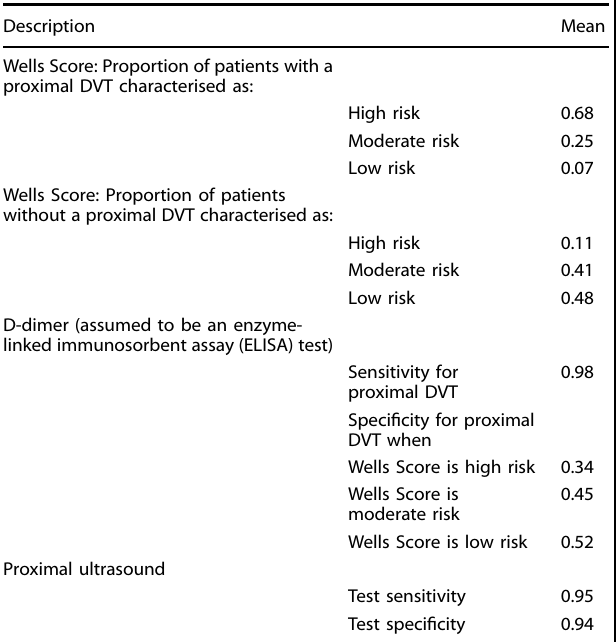
Table 9. Ef fi ciency parameters for each test.